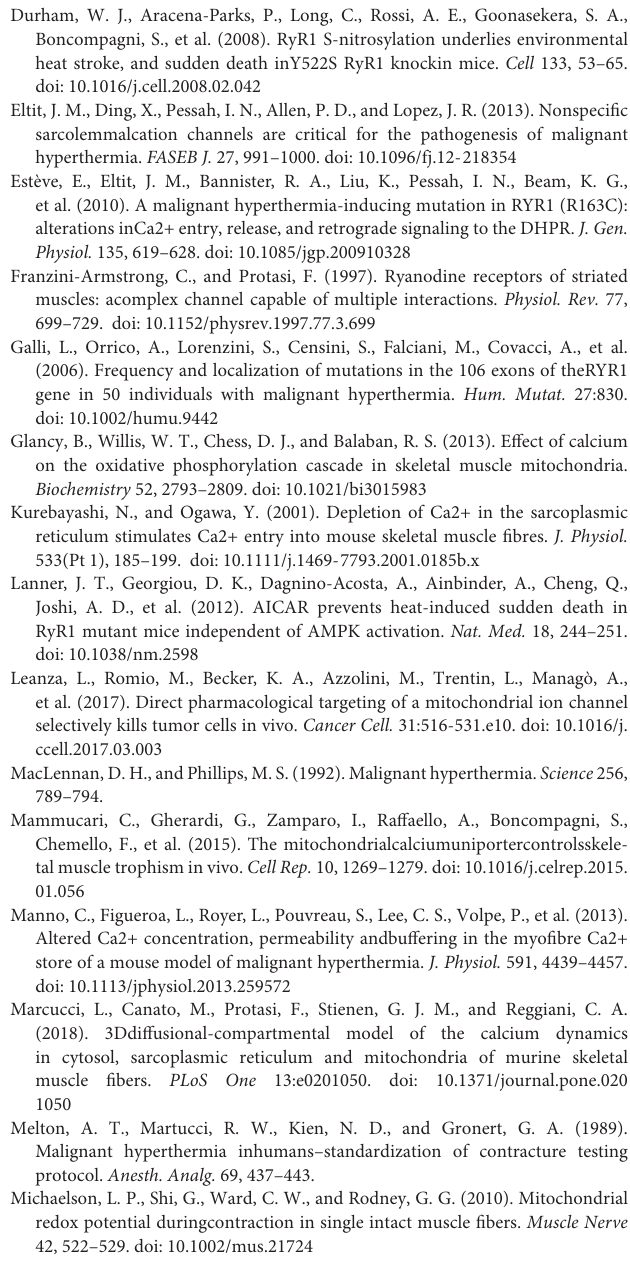
FIGURE S1 | Quantitative determination of the expression levels of four components of MCU complex as obtained with Q-PCR. Levels in WT muscles are taken as reference. FIGURE S2 | Cytosolic calcium concentration determined as fluorescence ratio of Fura-2 in WT and YS muscle fibers exposed to caffeine with or without